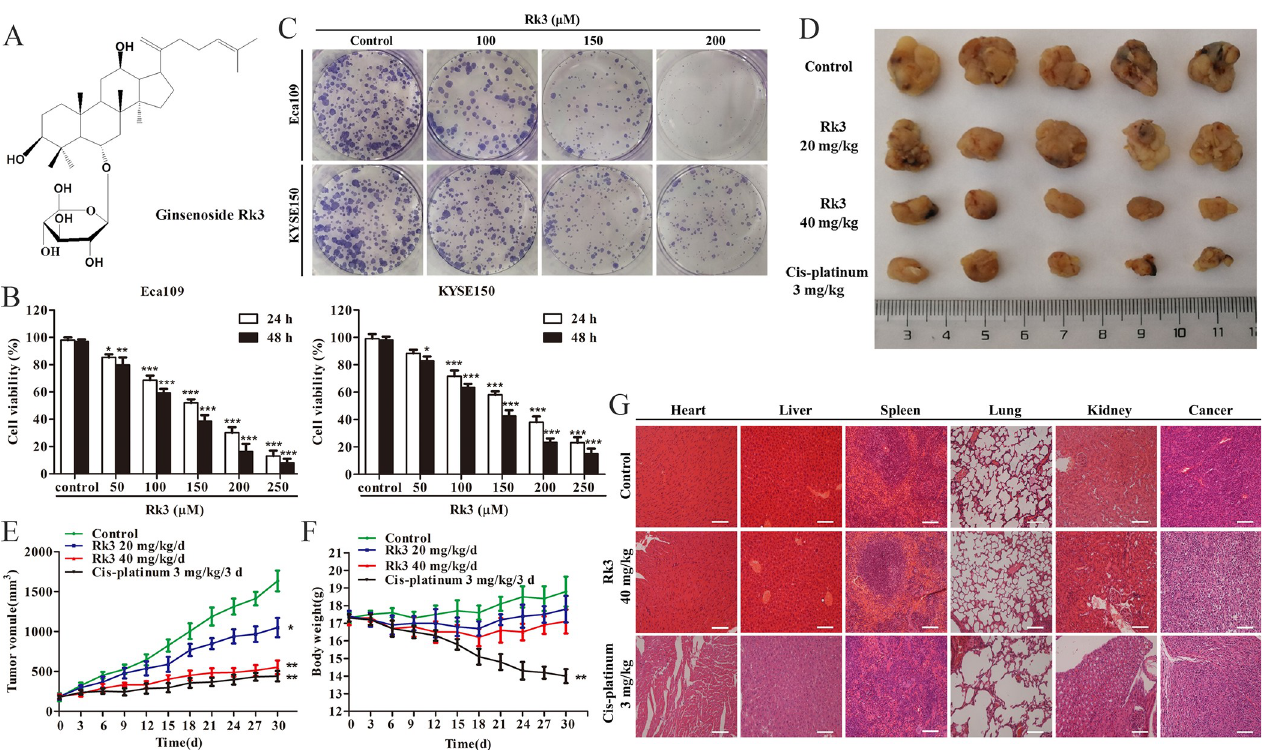
Fig 1. Anti-esophageal cancer effects of the ginsenoside Rk3 in vitro and in vivo . (A) The chemical structure of the ginsenoside Rk3. (B) Cell viability was measured by the MTT assay. (C) Colony formation. (D) Representative image of the tumor. (E) Tumor volume. (F) Body weight of mice. (G) H&E staining of major organs and tumors. � p < 0.05, �� p < 0.01 and ��� p < 0.001 compared with